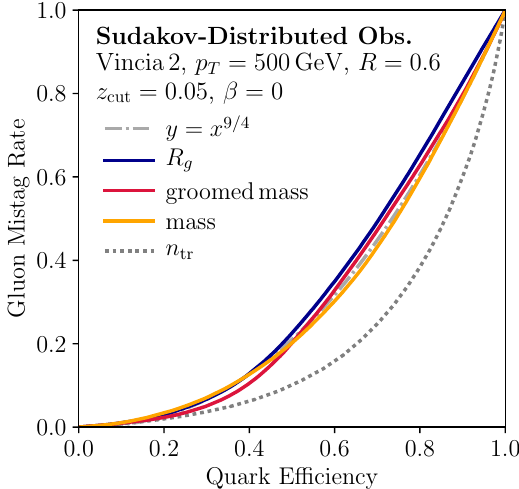
Figure 4. Comparison of the quark/gluon ROC curves for various Sudakov-distributed observables to the y = x 9 = 4 prediction from Casimir scaling. Shown are the groomed jet radius, groomed jet mass, and ordinary jet mass. As a useful benchmark, we also show the performance of track multiplicity n tr , which is known to be a very strong discriminant.